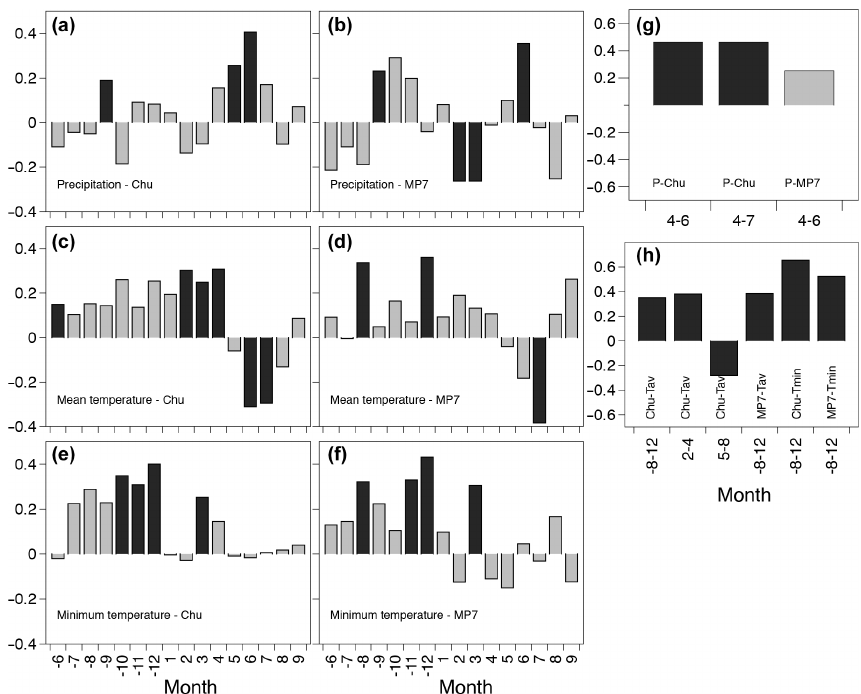
Figure 4. Correlations between the monthly mean meteorological data and VUS chronology. (a, c, e) Chuguevka (Chu) and VUS chronology; (b, d, f) VUS meteorological station (MP7) and VUS chronology; (g) correlation coefficients between VUS chronology and the precipitation of different month combinations; (h) correlation coefficients between VUS chronology and the temperature of different month combinations. The black bars are significant